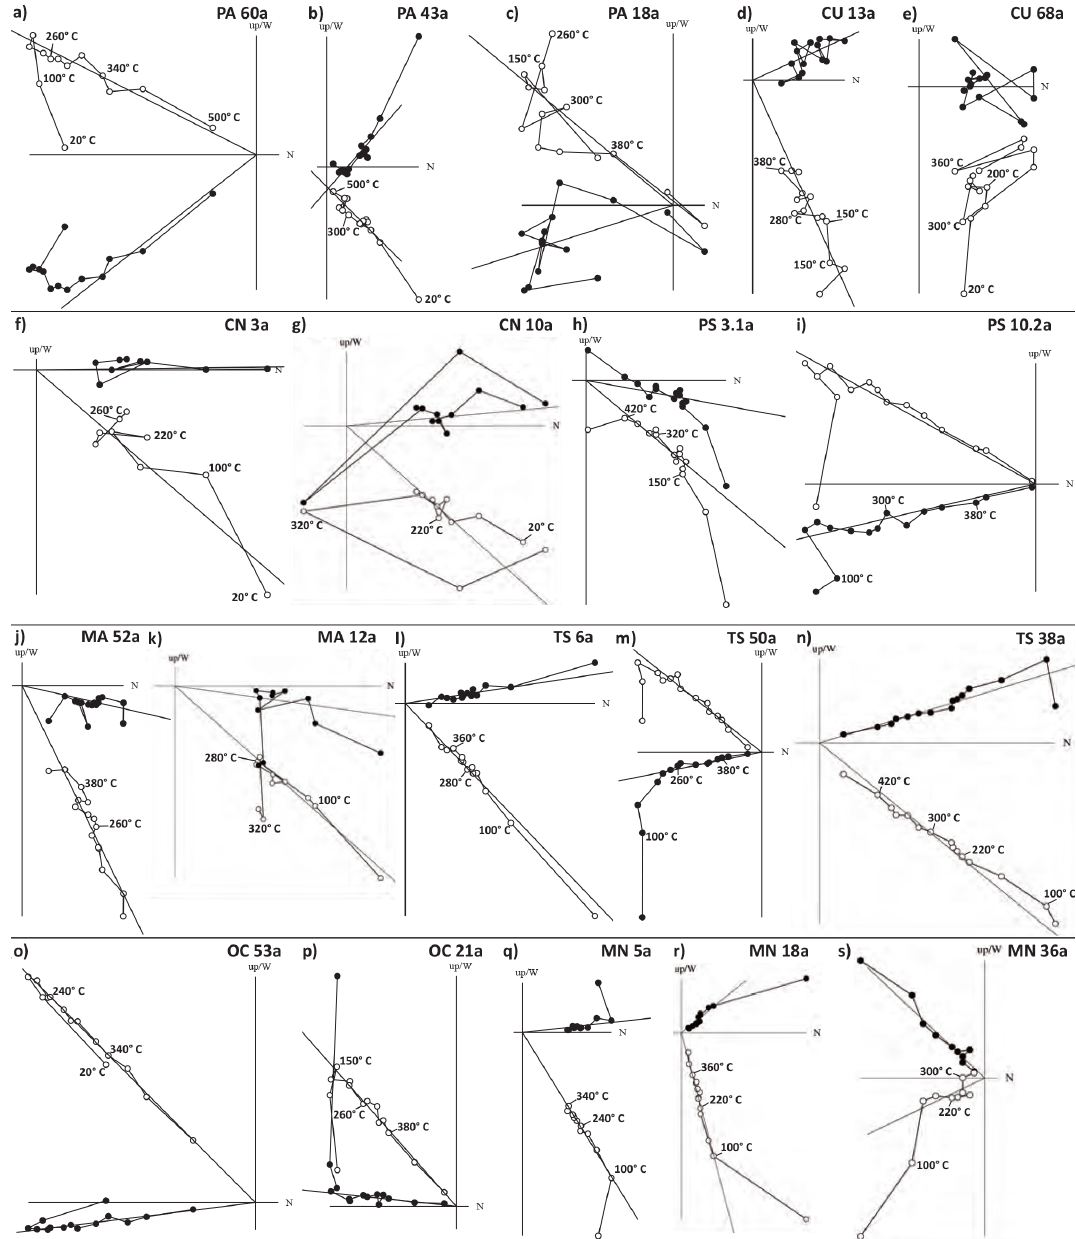
Figure 4. Orthogonal vector diagrams (Zijderveld, 1967), showing representative demagnetization diagrams for all sampled sites. Except for OC, TS and MN all sites are in tilt-corrected coordinates. Closed (open) circles indicate the projection on the horizontal (vertical)